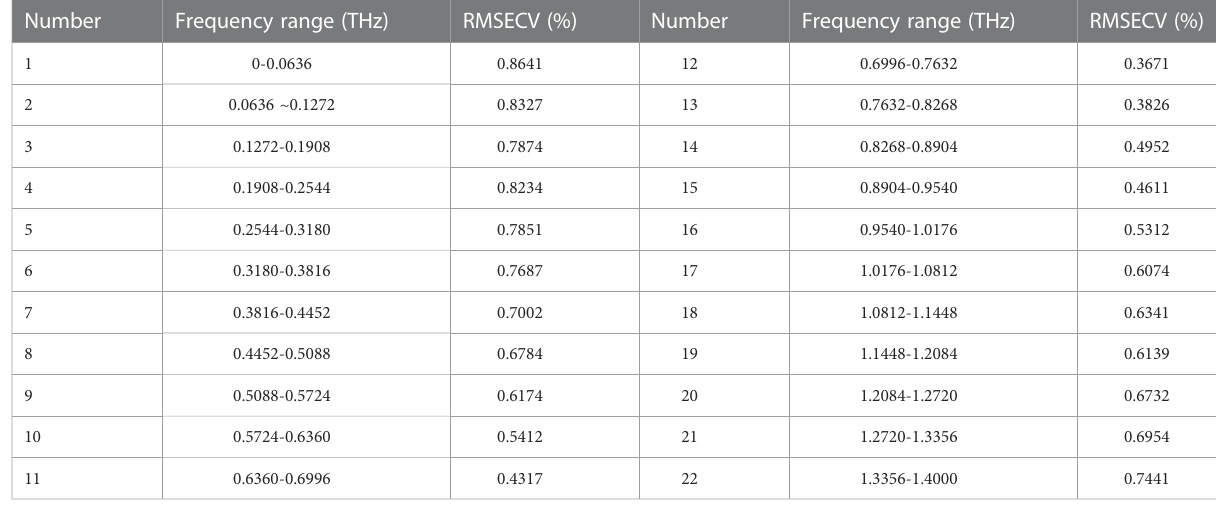
TABLE 2 The index values of each subinterval